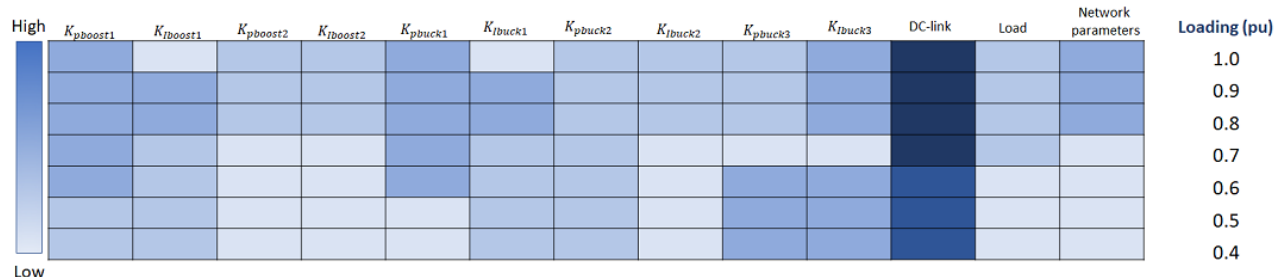
Figure 12. Heatmap of ranking critical parameter for oscillatory stability.